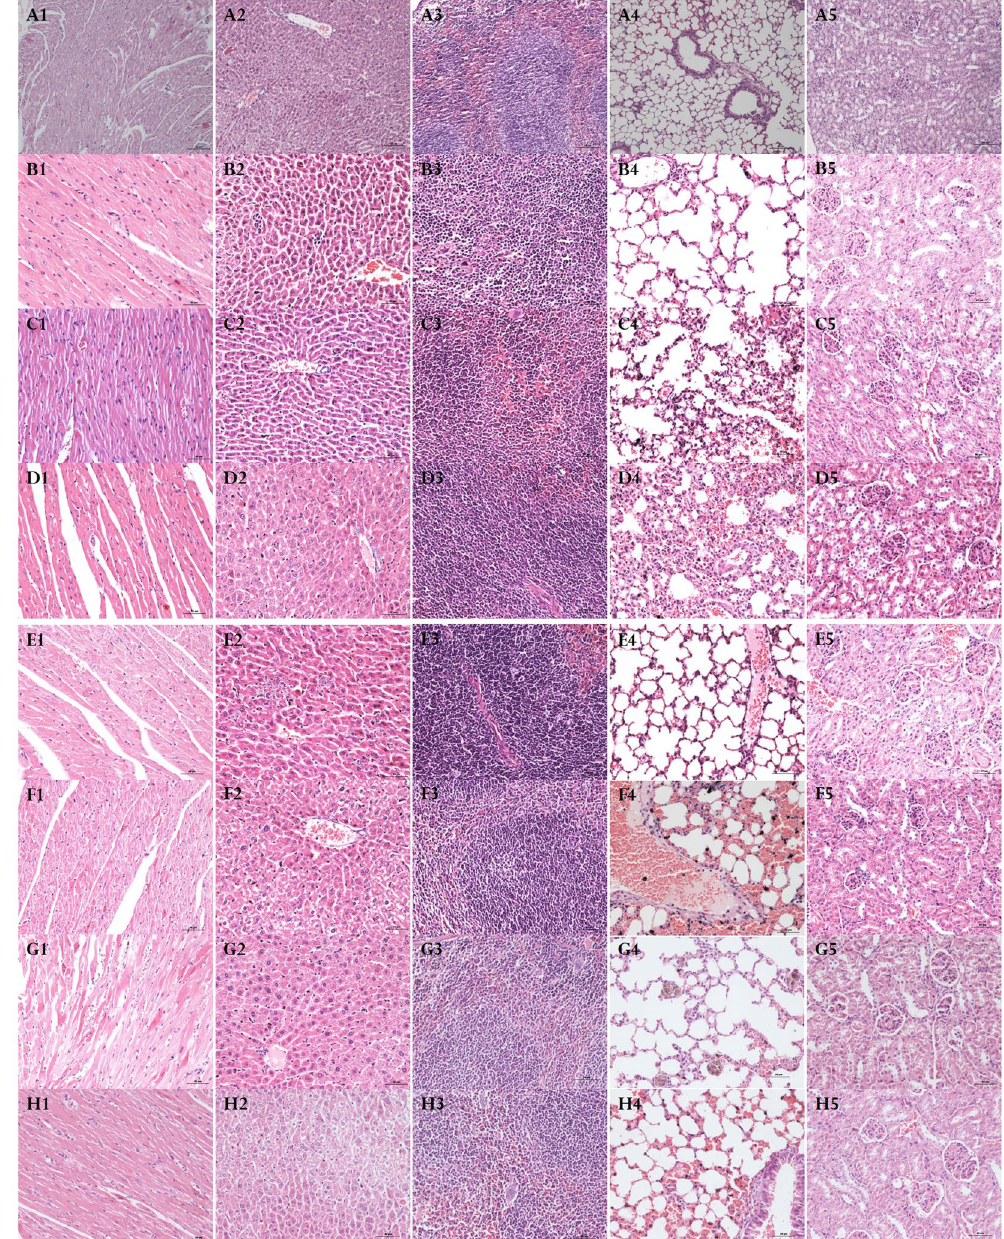
Figure 5. The tissue histology (200 × , scale bar is 50 μ m for B–G groups, and scale bar is 100 μ m for A group) investigation after exposure different drugs (A1–A5 for tissues of heart, liver, spleen, lung and kidney of control group mice, respectively; B1-B5 for tissues of heart, liver, spleen, lung and kidney of oMWCNTs- model group mice, respectively; C1–C5 for tissues of heart, liver, spleen, lung and kidney of oMWCNTs- model + DOPC group mice, respectively; D1–D5 for tissues of heart, liver, spleen, lung and kidney of oMWCNTs-model + TD group mice, respectively; E1–E5 for tissues of heart, liver, spleen, lung and kidney of TD-model + oMWCNTs group mice, respectively; F1–F5 for tissues of heart, liver, spleen, lung and kidney of DOPC-model + oMWCNTs group mice, respectively; G1–G5 for tissues of heart, liver, spleen, lung and kidney DOPC + oMWCNTs group mice, respectively; H1–H5 for tissues of heart, liver, spleen, lung and kidney of TD + oMWCNTs group mice,